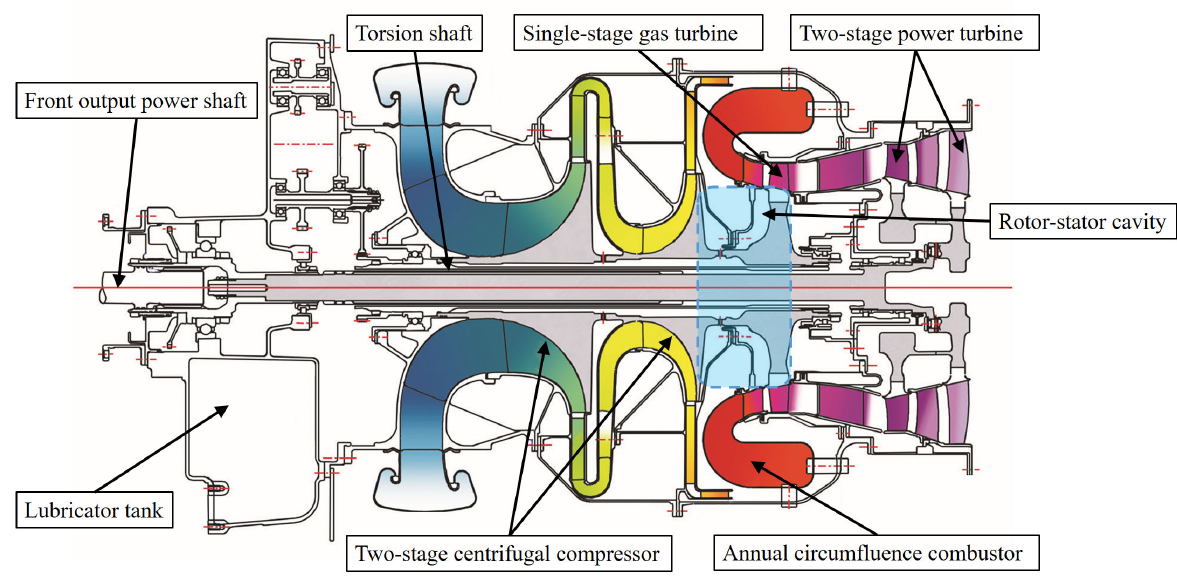
Figure 1. A certain type of turboshaft engine [35].